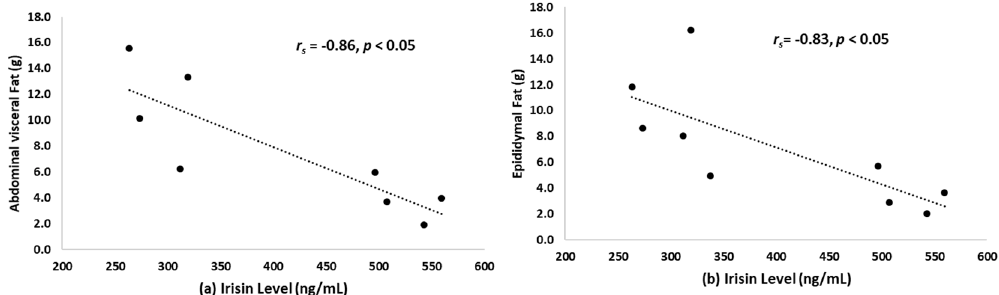
Figure 1. ( a ) The correlation between abdominal visceral fat (g) and irisin level; ( b ) the correlation between epididymal fat (g) and irisin level.